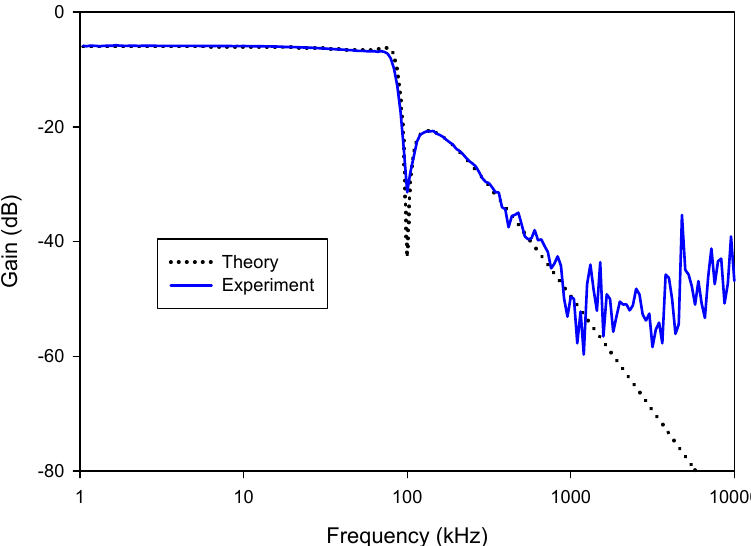
Figure 40. The experimental frequency responses of the LP ladder filter based on VD-DIBA compared with the theoretical response of the RLC prototype filter.